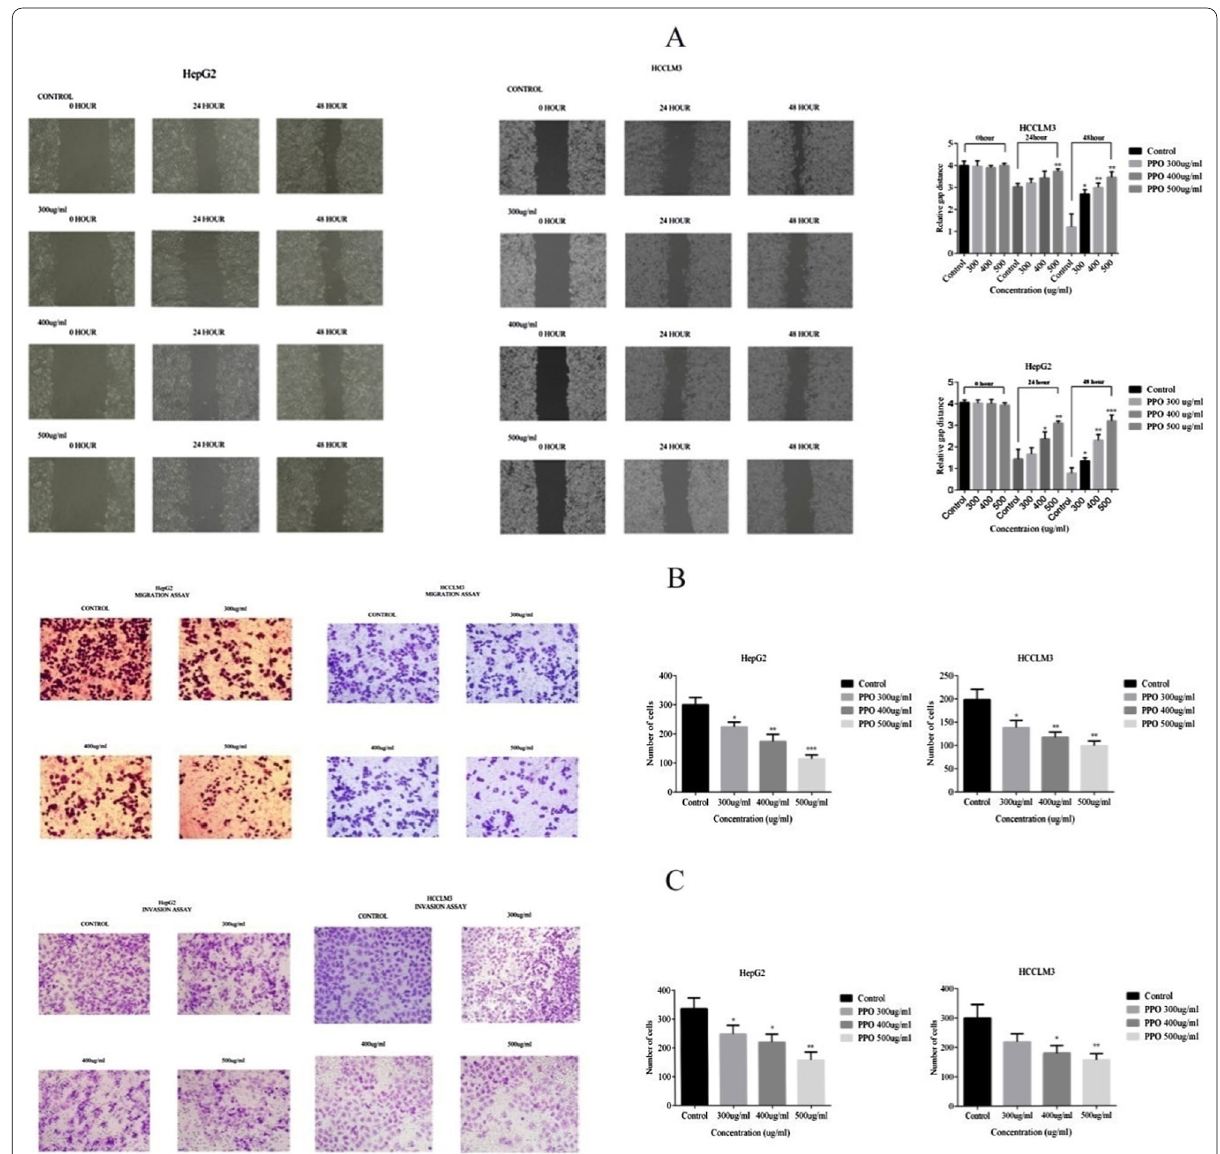
Fig. 5 Polysaccharide affects anti-metastatic abilities of cancer cells A Wound closure assay was performed and observe the significant difference between Control and polysaccharide treated cells after comparing relative gap distance in HepG2 and HCCLM3. B To observe the anti-migratory abilities of polysaccharide in HepG2 and HCCLM3, transwell chambers assay was performed and the difference was observed in decrease number of migrated cells in a dose-dependent manner C Transwell chamber was used for invasion assay and the results suggest that there is a significant difference as compared to control group and observed a decrease in the invaded number of cells in a dose-dependent manner. *p < 0.05, **p < 0.01, ***p 0.001. *PPO (Polysaccharide from Pleurotus ostreatus ), *CTX ≤